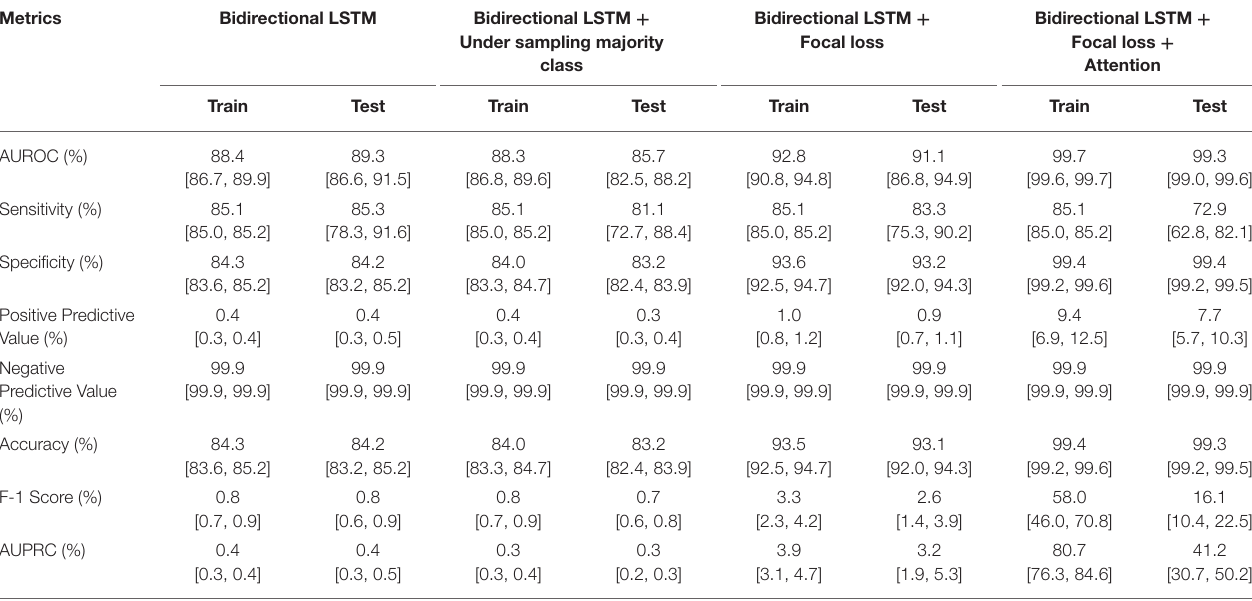
TABLE 2 | Performance metrics of the deep learning models in predicting PSI * in the next 48h of hospitalization.